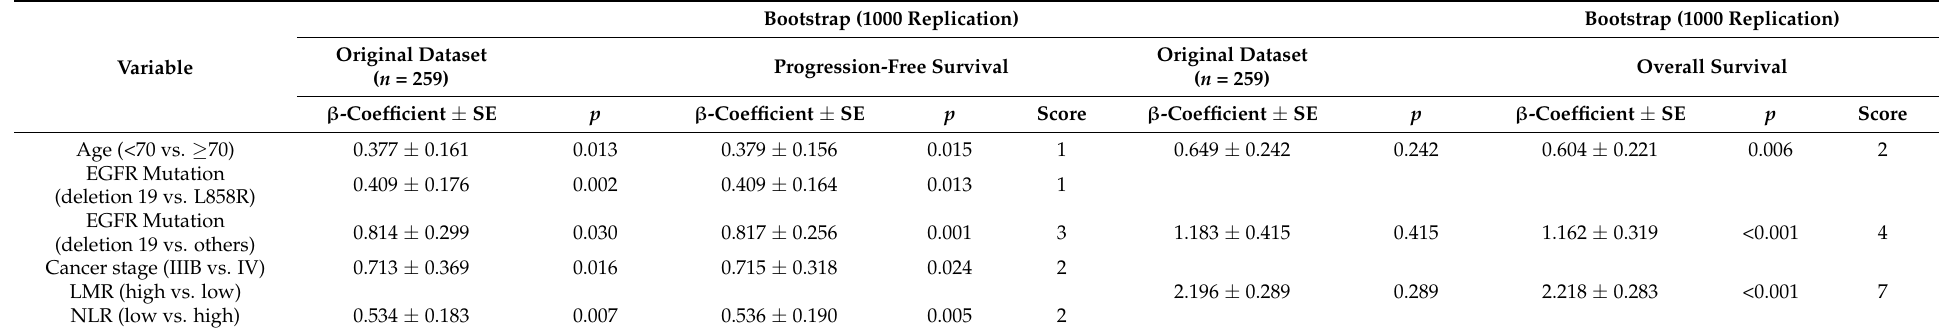
Table 5. Multivariate Cox regression coefficients and prognostic scoring